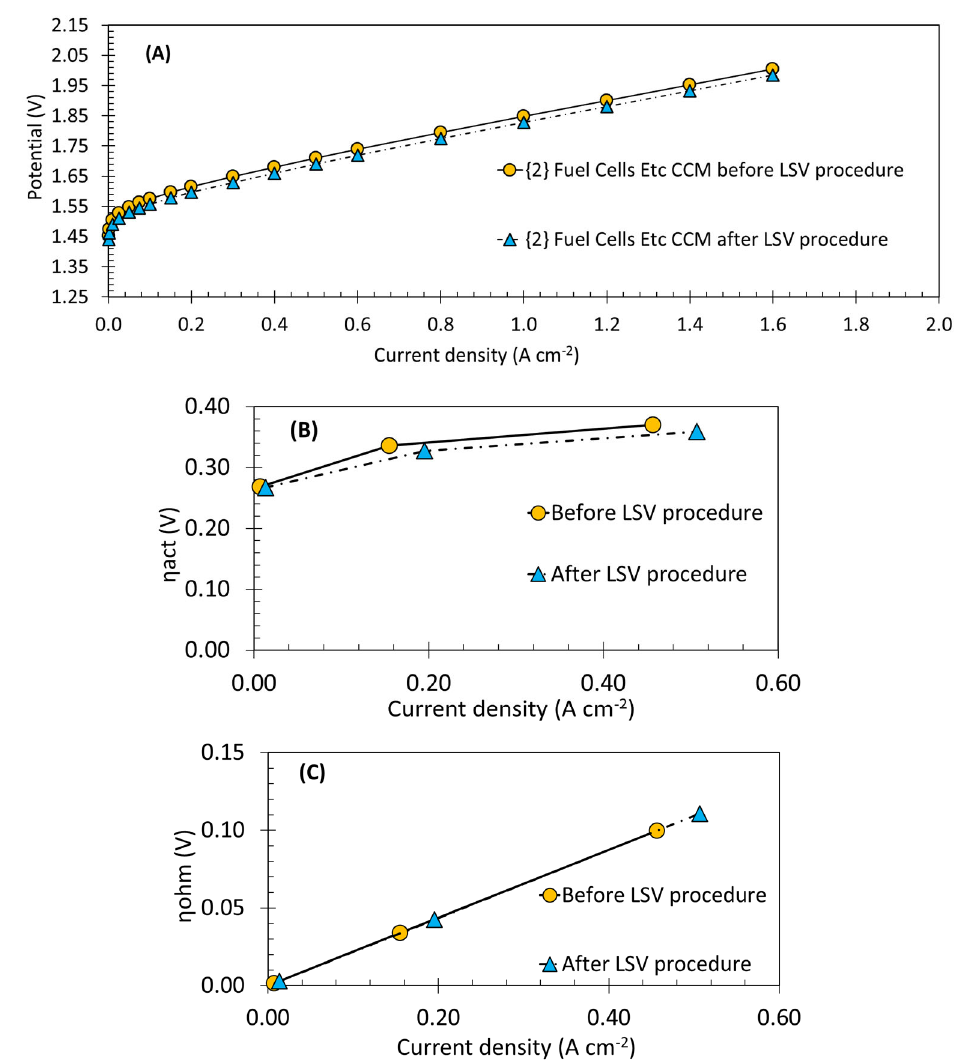
Figure 7. Hydrogen anode purge temporary effect on the performance, with WE operating with QuinTech CCM. ( A ) ‐ I ‐ V curves, ( B ) ‐ activation overpotentials, ( C ) ‐ ohmic overpotentials.